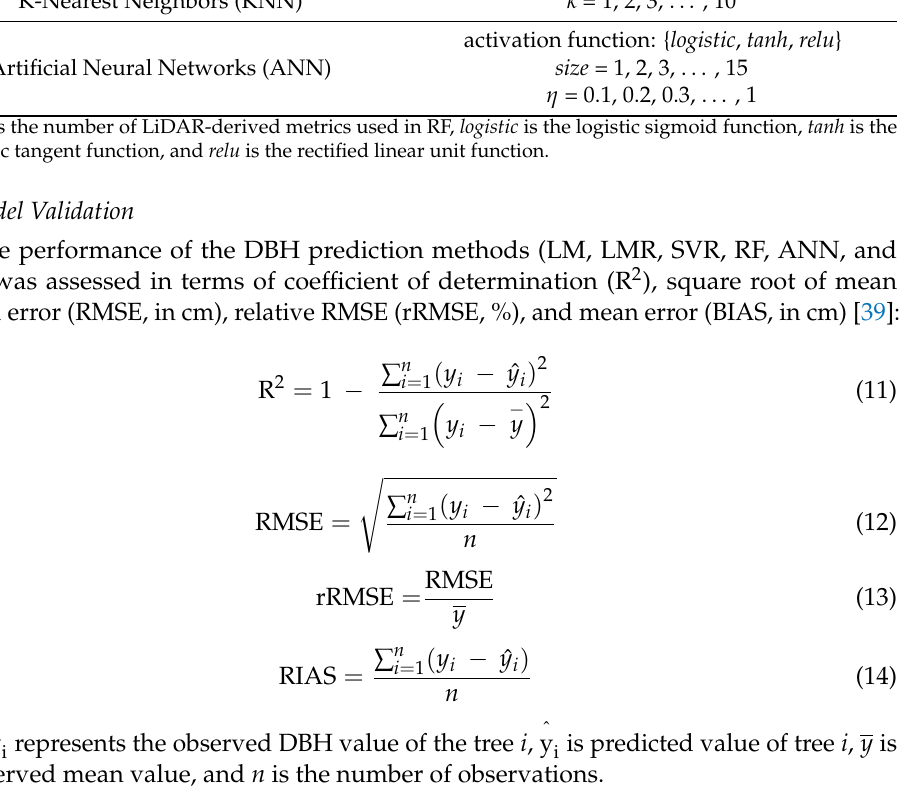
activation function: { logistic , tanh , relu } size = 1, 2, 3, . . . ,